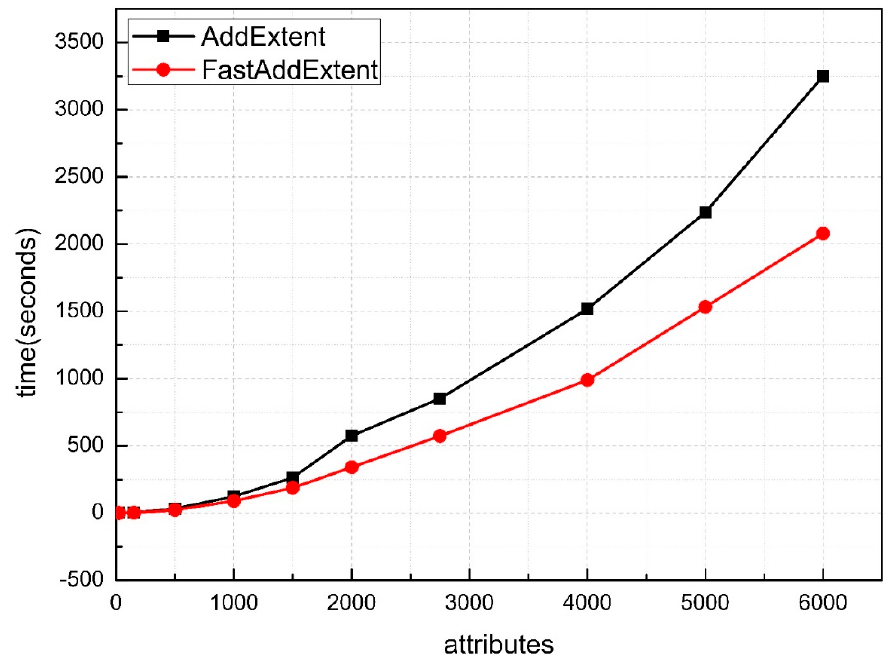
Figure 5. Results for random datasets with medium density.